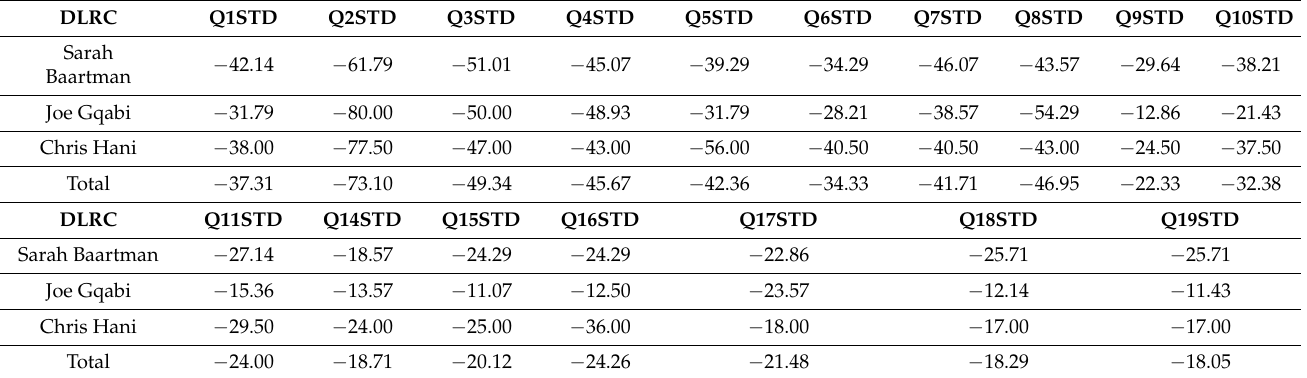
Table 7. Discrepancies between actual and preferred situation (average